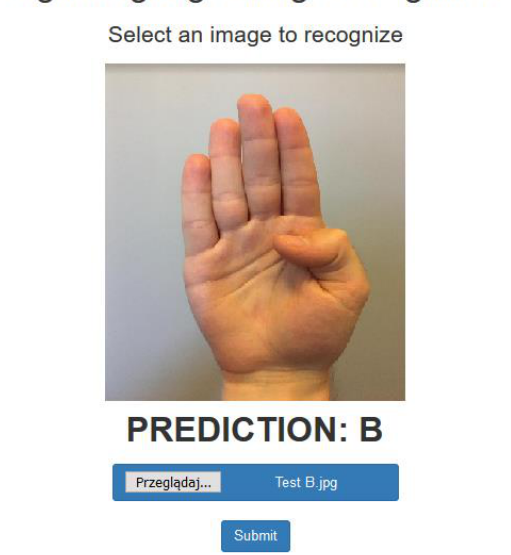
Figure 2. Visualization of the application interface showing the verification result.